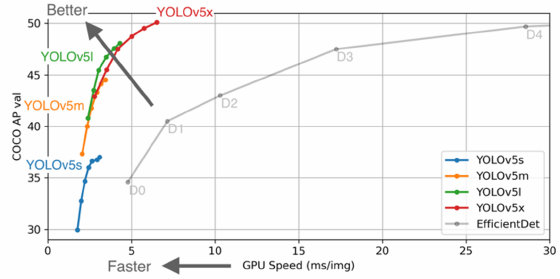
Figure 1: Comparison of various sized models of the YOLOv5 family in terms of speed and accuracy of detection (adapted from (Jocher et al., 2020)). The more the plots tend to the top-left corner, the better the performance of the model.